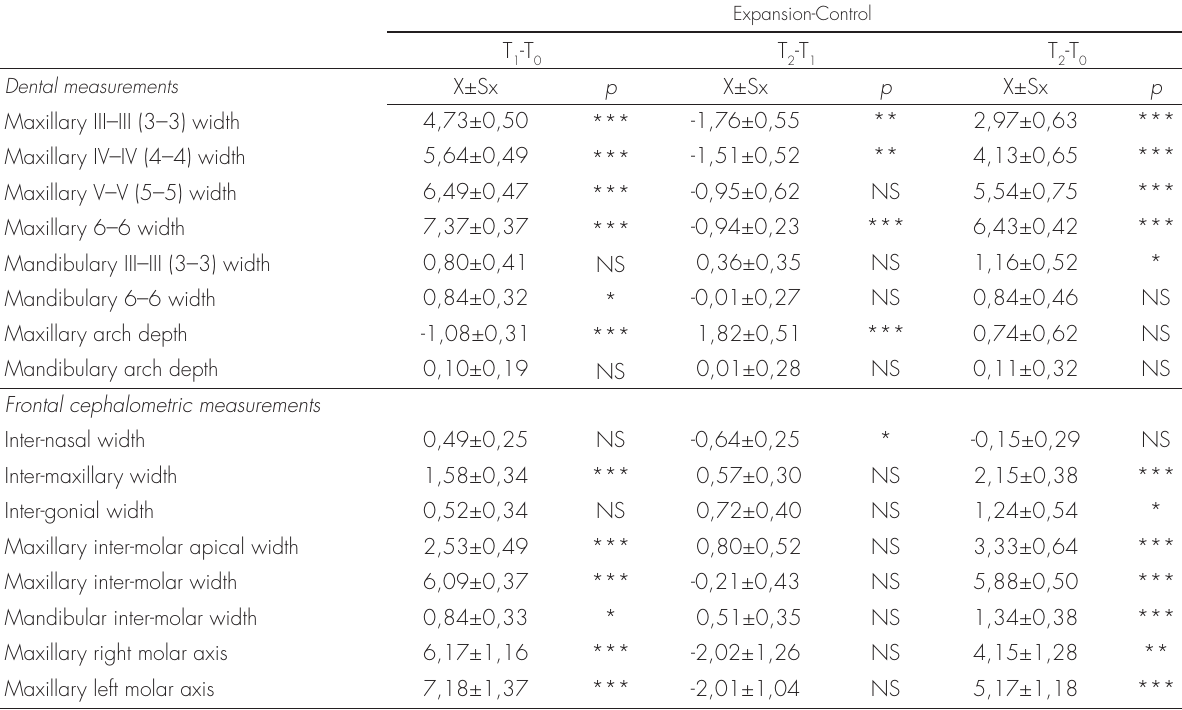
Table III. Mean differences in dental and frontal cephalometric measurements during different